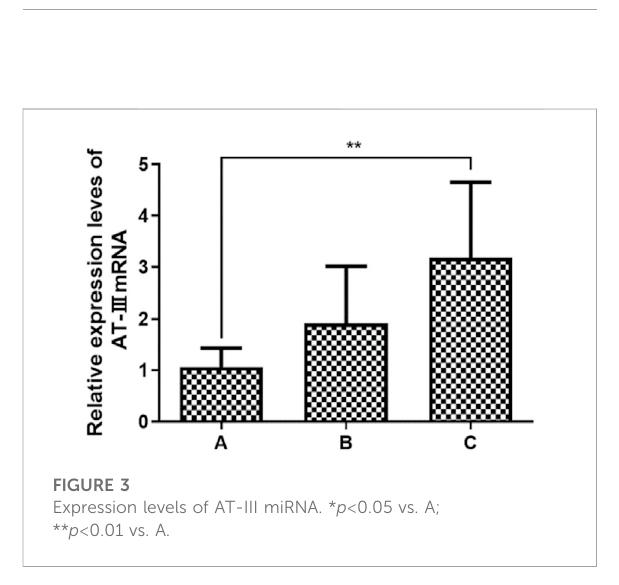
FIGURE 3 Expression levels of AT-III miRNA. * p < 0.05 vs. A; ** p < 0.01 vs. A.